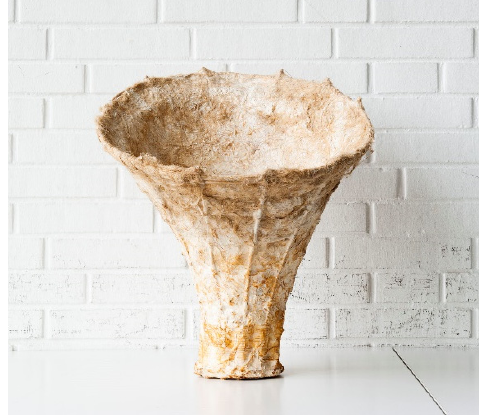
Figure 13. First Prototype.